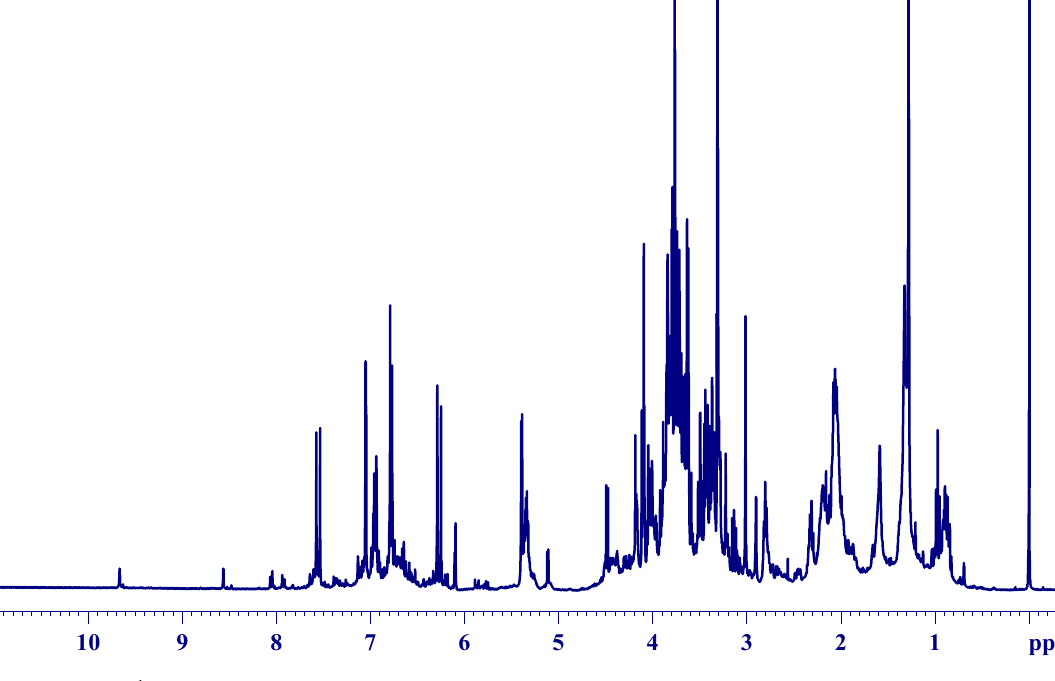
Figure 3. 1 H HR-MAS NMR ( δ − 0.50–11.00) spectrum from the leaves of Berberis laurina (400 MHz, ~10 mg swollen in 40- µ L CD 3 OD).